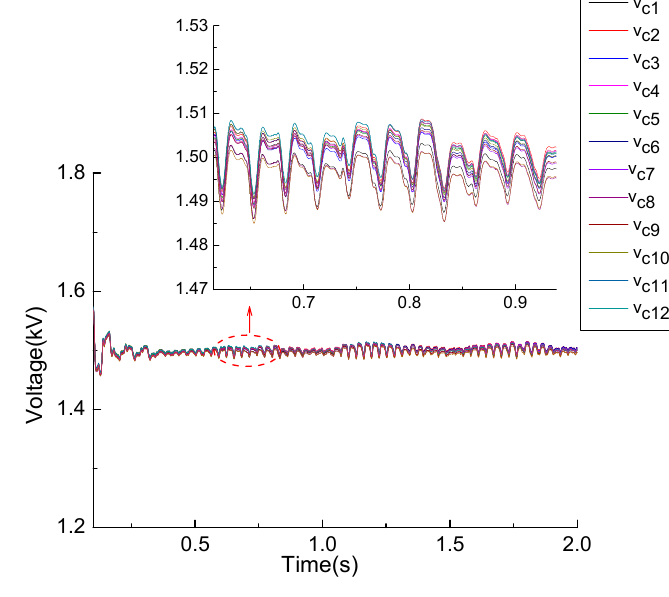
Figure 6. Capacitor voltages. 149